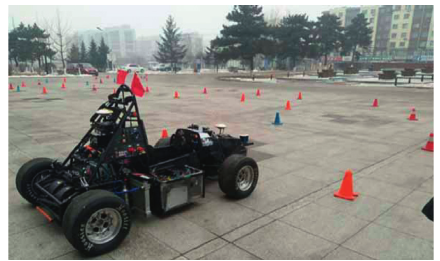
Figure 20: Actual car test